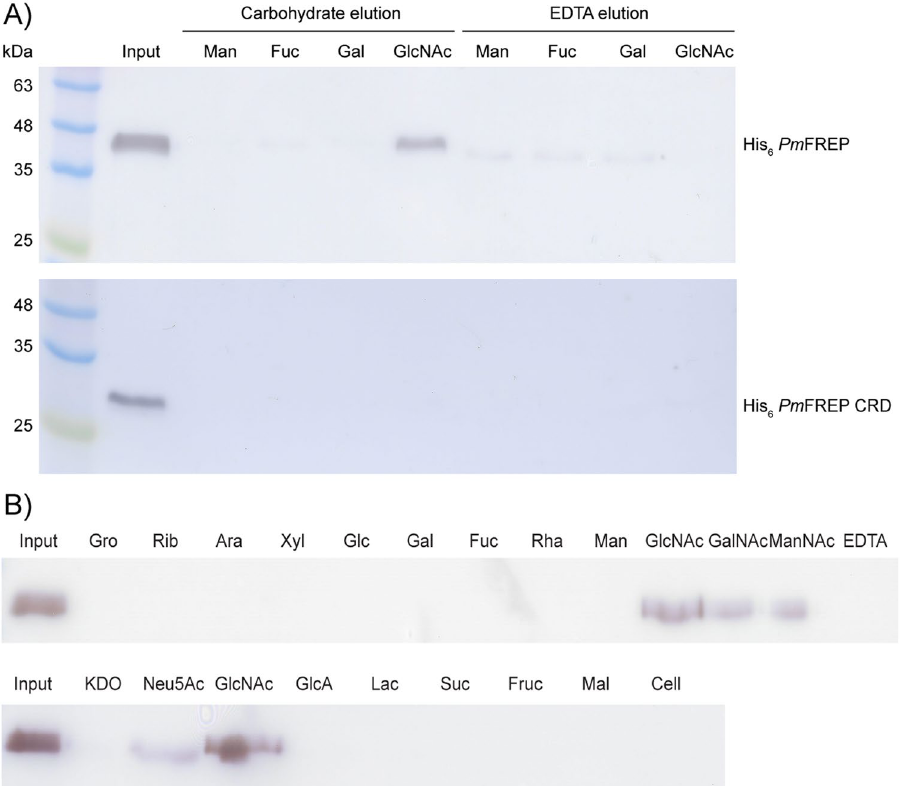
Figure 5. ( A ) Western blot analysis of His 6 Pm FREP (top panel) and His 6 Pm FREP CRD (bottom panel) bound to different carbohydrate resin and eluted with either the respective monosaccharide or EDTA. ( B ) Competitive elution of His 6 Pm FREP bound to GlcNAc resin by different soluble carbohydrates. Anti-His 6 antibody was used as the primary antibody.